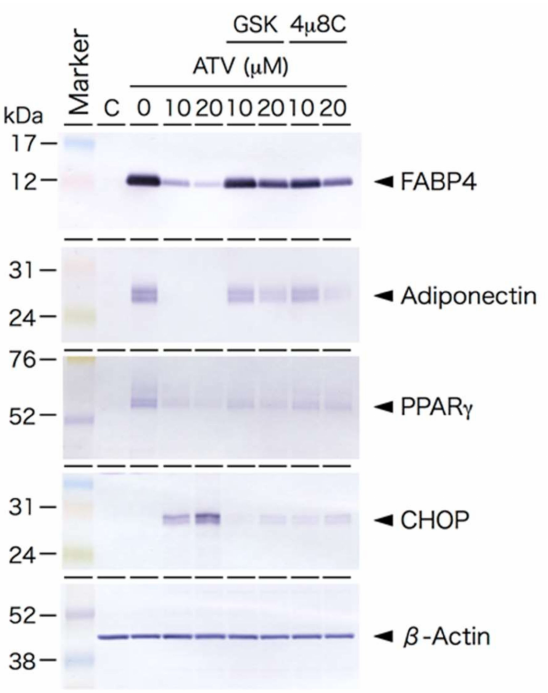
Figure 6. Induction of discrete foci of CHOP during adipogenesis of ADSCs treated with ATV. ADSCs, cultured in a serum-free medium until they reached confluence, were incubated in adipogenic differentiation medium for 7 days with varying concentrations of ATV. Images were taken under a fluorescence microscope. Green punctate fluorescence signals indicate CHOP. Green fluorescence was divided by blue fluorescence to calculate CHOP expression/cell. C, control. White scale bar indicates 100 μ m. The experiments were repeated three times.